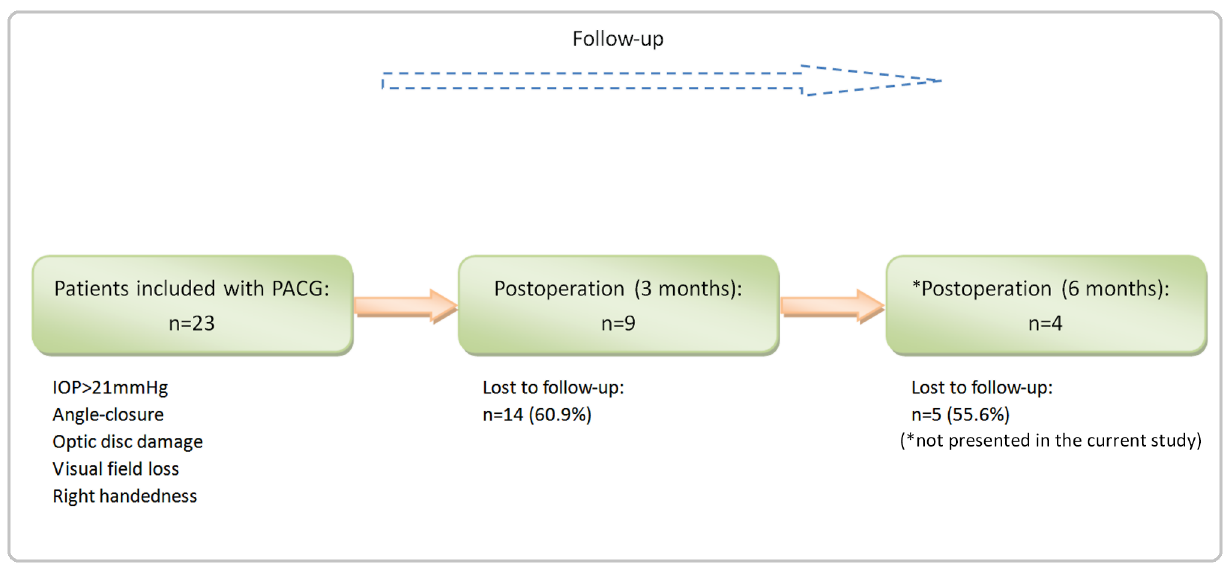
Fig 1. Schematic of recruiting procedures for the patients in this study. For the patients, we acquired brain MRI data and performed a complete ophthalmologic examination at three time points: before surgery and at three and six months after surgery. Due to poor compliance and a lack of transportation, we only included 9 patients three months after surgery and 4 patients six months after